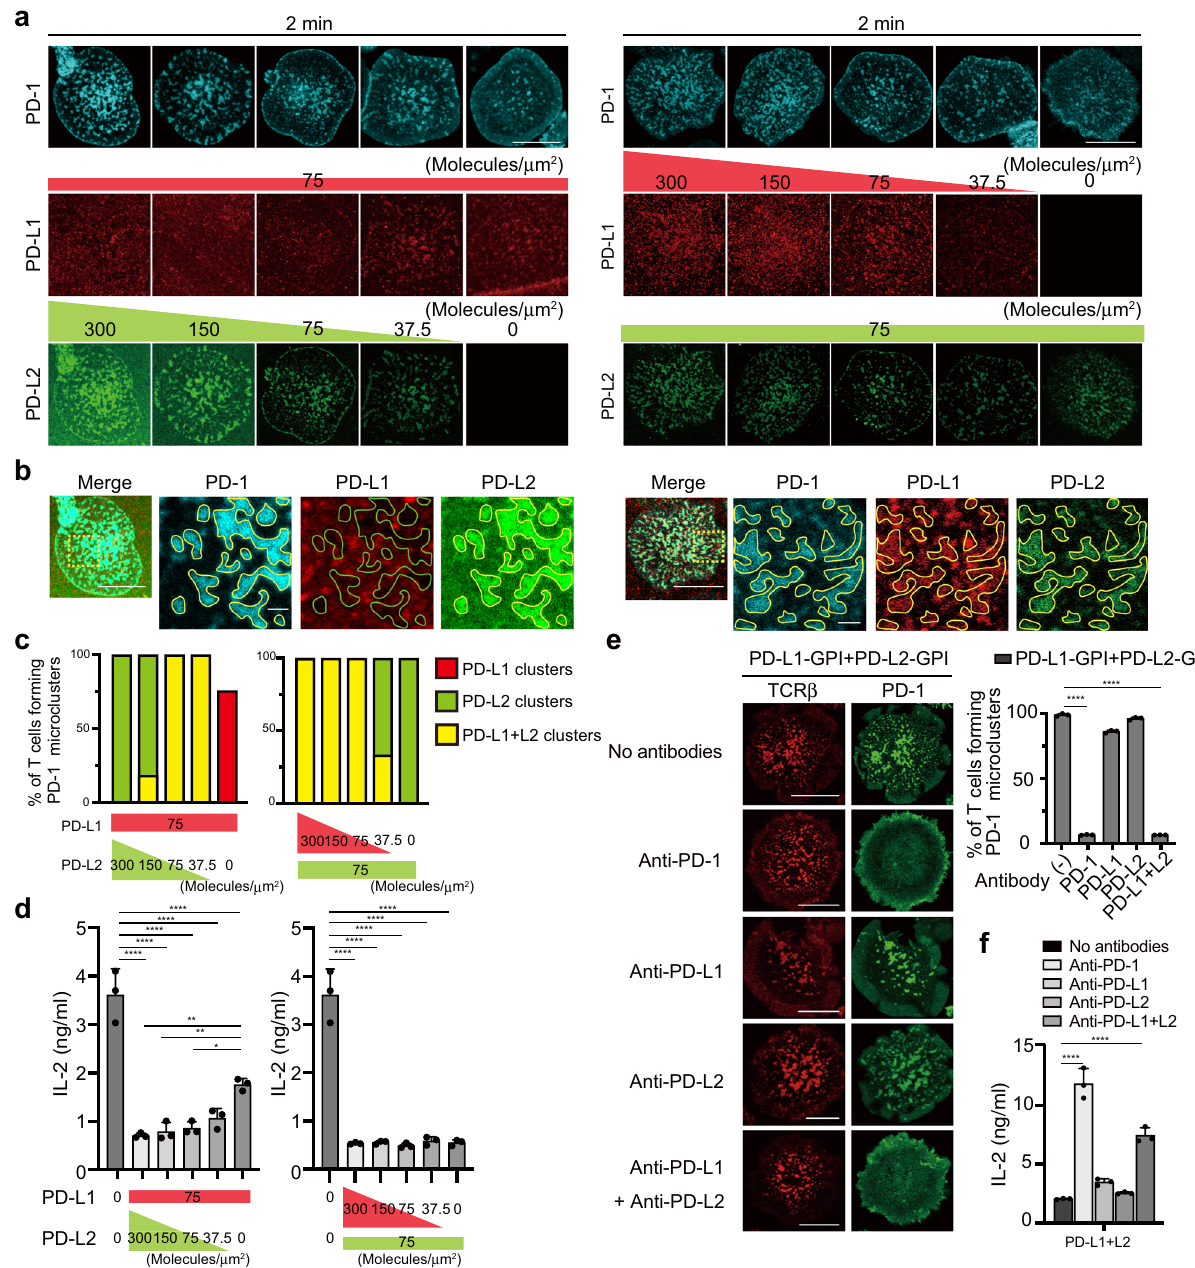
Fig. 5 PD-L2 outcompetes PD-L1 in binding to PD-1 at the TCR – PD-1 microclusters. a The mPD-L1 – GPI (red, middle) and mPD-L2 – GPI (green, bottom) were labeled with AlexaFluor 647 and AlexaFluor 488, respectively, and reconstituted into SLBs as in Fig. 1a in the different densities indicated above the images. 2D12 expressing mPD-1 – HaloTag (top, cyan) were preincubated with HaloTag ligand – TMR and real-time imaged by confocal microscopy at 2 min after the T cell-bilayer contact. b Images of cells in a at mPD-L1 – GPI (75 molecules/ μ m 2 ) + mPD-L2 – GPI (300) (left) or mPD-L1 – GPI (300) + mPD- L2 – GPI (75) (right). The yellow squares in the left panels are magni fi ed in the right three panels. Yellow enclosures show PD-L1 or PD-L2 clusters colocalized with PD-1 microclusters. Green enclosures show blank where PD-1 microclusters formed. c The graphs show the percentage of T cells forming PD-1 microclusters composed of either PD-L1, PD-L2, or PD-L1 + L2 at the different densities of mPD-L1 – GPI and mPD-L2 – GPI in a . d Silica beads were coated with the same SLBs as in a with different densities of mPD-L1 – GPI and mPD-L2 – GPI and prepulsed with MCC 88 – 103 to use as engineered antigen presenting cells. 2D12 expressing mPD-1 were stimulated by these silica beads for 16 h and the concentration of IL-2 in each supernatant was measured by ELISA. e 2D12 expressing mPD-1 – EGFP (green) were prestained with DyLight 650-labeled H57 Fab (red) and real-time imaged on an SLB with both mPD- L1 – GPI and mPD-L2 – GPI in the absence or presence of each antibody as in Fig. 2a. The graph shows the percentage of T cells forming PD-1 microclusters ( n = 30). f The cells in e were stimulated by 16h-aggregation culture with 10 μ M of MCC 88 – 103 and the concentration of IL-2 in each supernatant was measured by ELISA. All data are representatives of three independent experiments. Bars, 5 μ m. Error bars, SD. Statistical analysis was by one-way analysis of variance (ANOVA). * p < 0.05, ** p < 0.01, **** p <